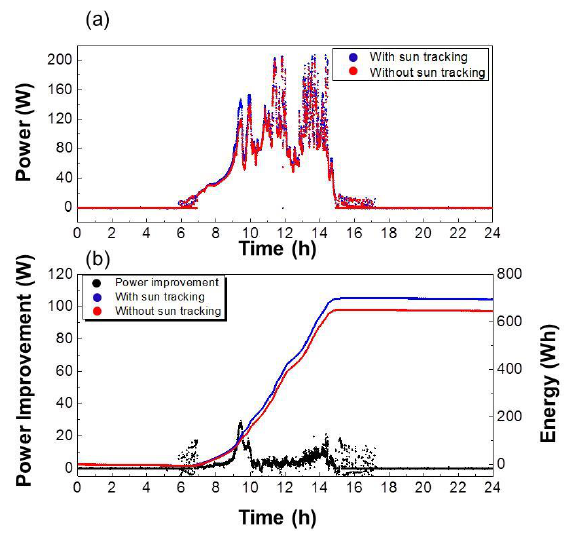
Figure 7. ( a ) Power generation and ( b ) power improvement and energy gain on a cloudy